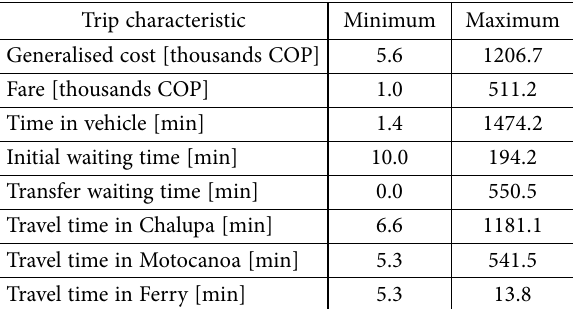
Figure 6. Flow Table 5. Minimum and maximum values of trip variables